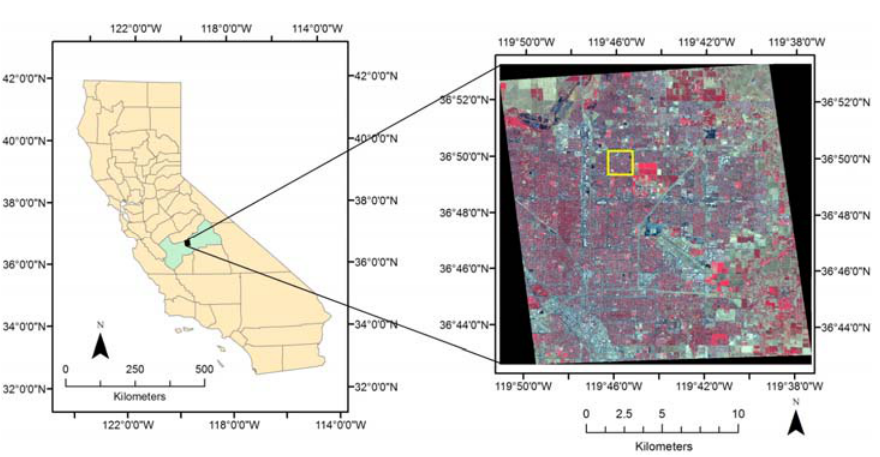
Figure 1. The State of California, USA with the County of Fresno shaded in green ( left ). Near infrared (NIR), red, and green false color composite (represented by red, green, and blue color layers) of the QuickBird image (copyright 2013) containing the study area represented by the yellow box ( right ). The image was acquired on 26 August 2007 at 1926